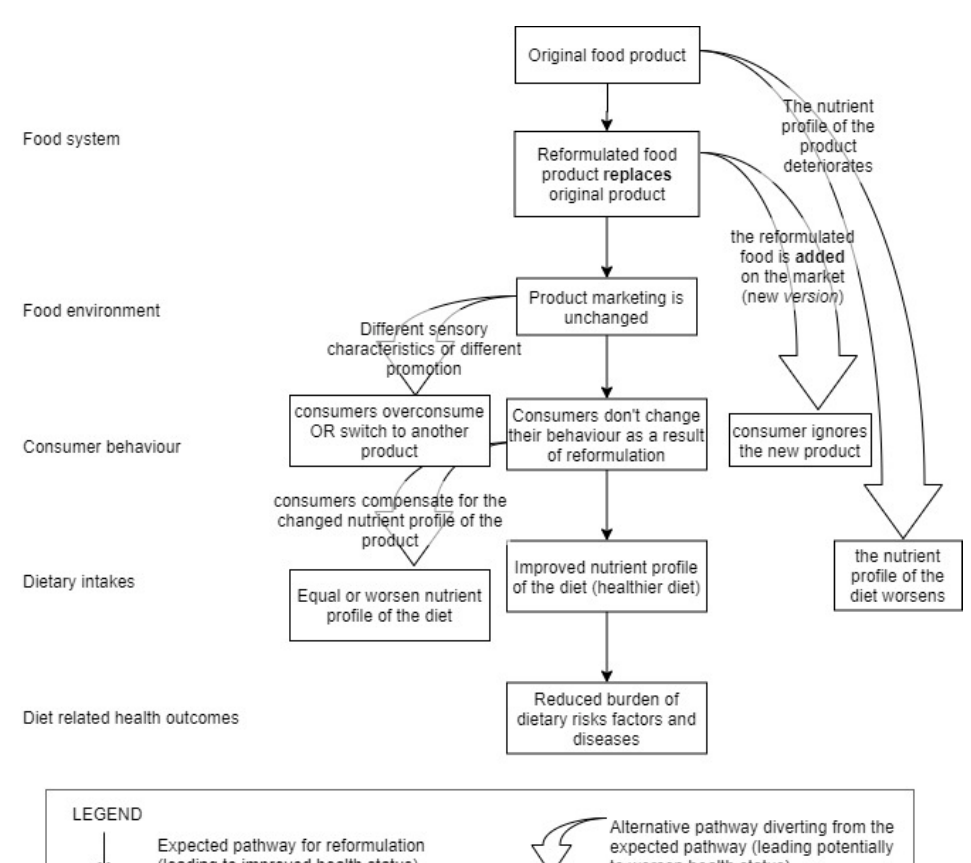
Figure 2. Logic model of the effect of reformulating existing food products, and sources of diversion from the expected health benefits.